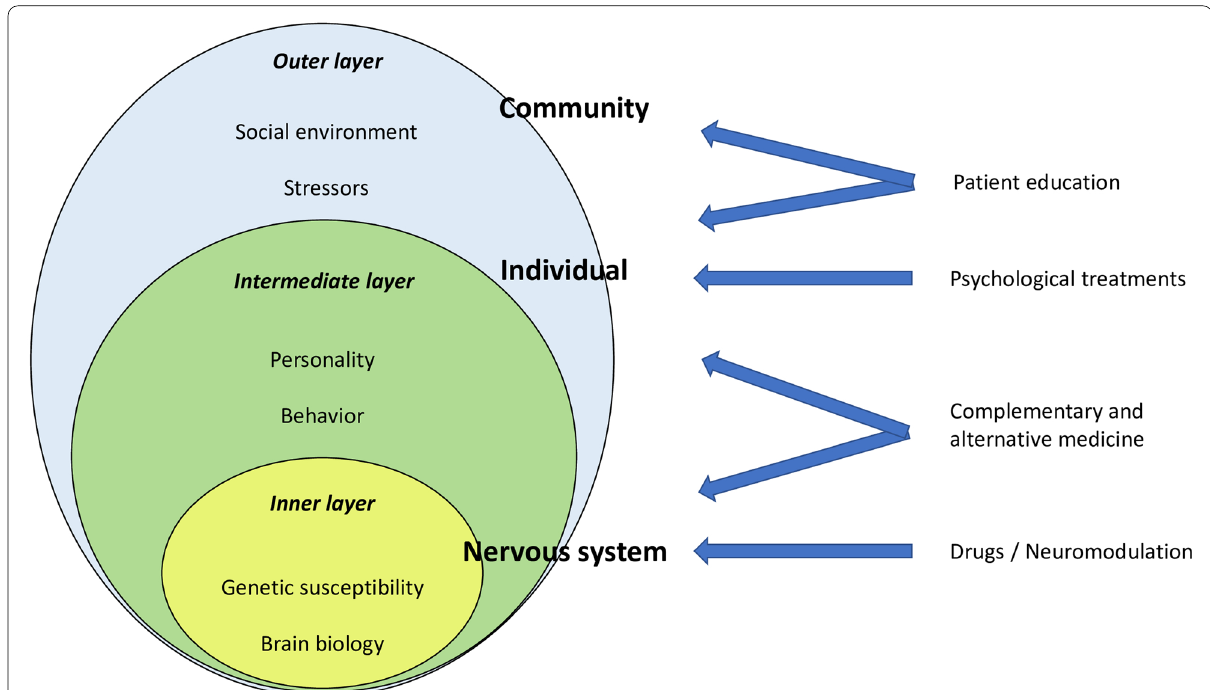
Fig. 4 A hierarchical view of the biopsychosocial model as applicable to